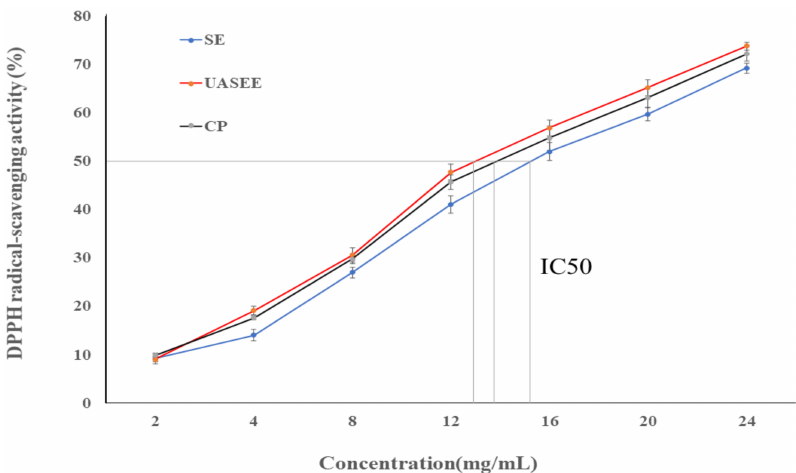
Figure 3. Antioxidant activity of E.mollis oil obtained by different methods.